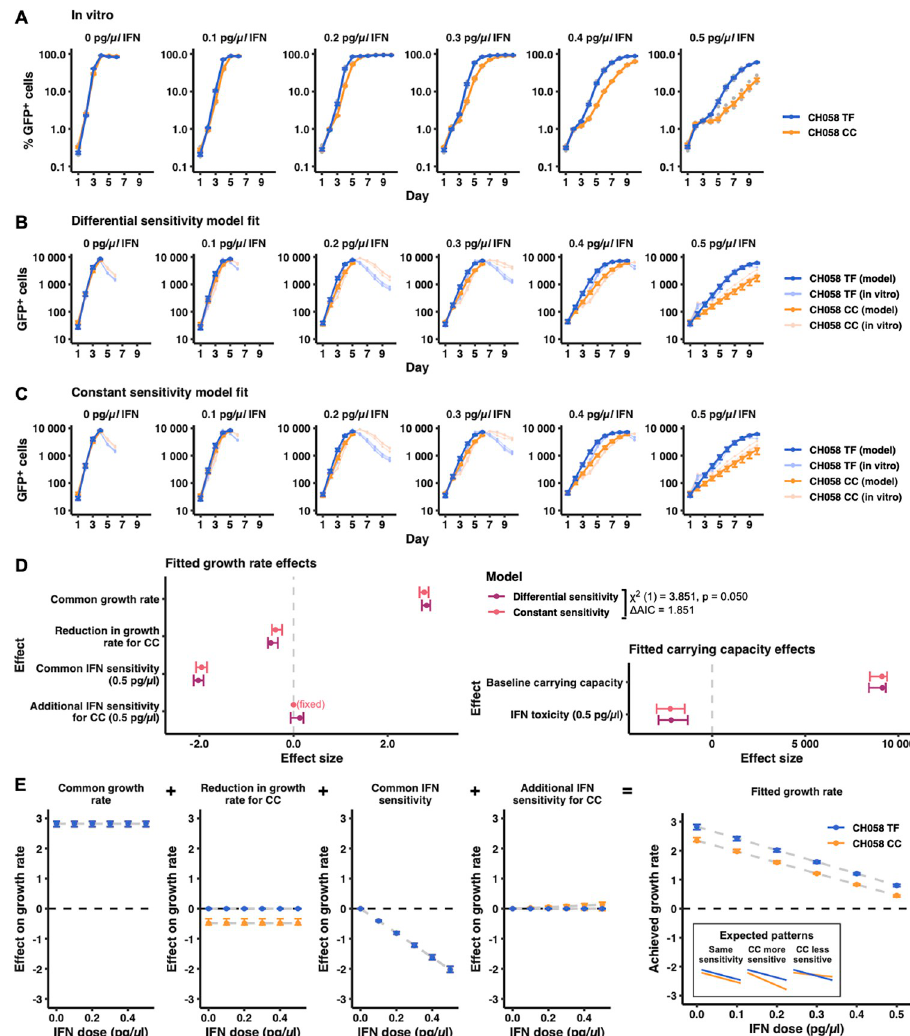
Fig 5. Statistical modelling of virus growth curves indicates that CH058 CC has a lower growth rate than its TF progenitor but is not otherwise more sensitive to IFN. (A) TMZR5 cells were pre-stimulated with different doses of IFN α 14 for 24 hours prior to infection with CH058 TF or CC virus and sampled daily to monitor virus spread. GFP- positive cells were enumerated using flow cytometry. Blue and orange points show means (+/- standard error) across 4 experimental replicates, while translucent points show individual observations. Viral spreading replication experiments took place on two occasions, a typical result is shown. (B) Model fit for the differential sensitivity model, in which viruses are allowed to vary in both baseline growth rate (i.e., growth rate in the absence of interferon) and in their sensitivity to interferon. (C) Model fit for the constant sensitivity model, in which viruses differ only in their baseline growth rate. In both B and C, opaque points show predictions from the fitted model, along with 95% confidence intervals. Translucent points and lines underneath show the observed (experimental) replicate growth curves also present in A. For each treatment, only the initial timepoints until at least one replicate curve decreased by > 30% relative to its preceding observation were used in model fitting (i.e. points after HIV-1 had overwhelmed the culture were not considered). (D) Effect sizes for both differential and constant sensitivity models (maximum likelihood estimates and 95% confidence intervals). Model fit was compared by likelihood ratio test and AIC, with results shown in the legend. (E) Illustration of effects making up the fitted growth rates in the differential sensitivity model. Effects were modelled as additive, allowing us to separate discrete contributions to the growth rates needed to recapitulate the in vitro data as illustrated in B. Points show maximum likelihood estimates, while error bars show 95% confidence intervals. An inset in the final panel (right) illustrates expected patterns under different hypothesized scenarios; in particular, if the CC virus was more sensitive to IFN, its achieved growth rate would have diverged from that of the TF virus at increasing IFN